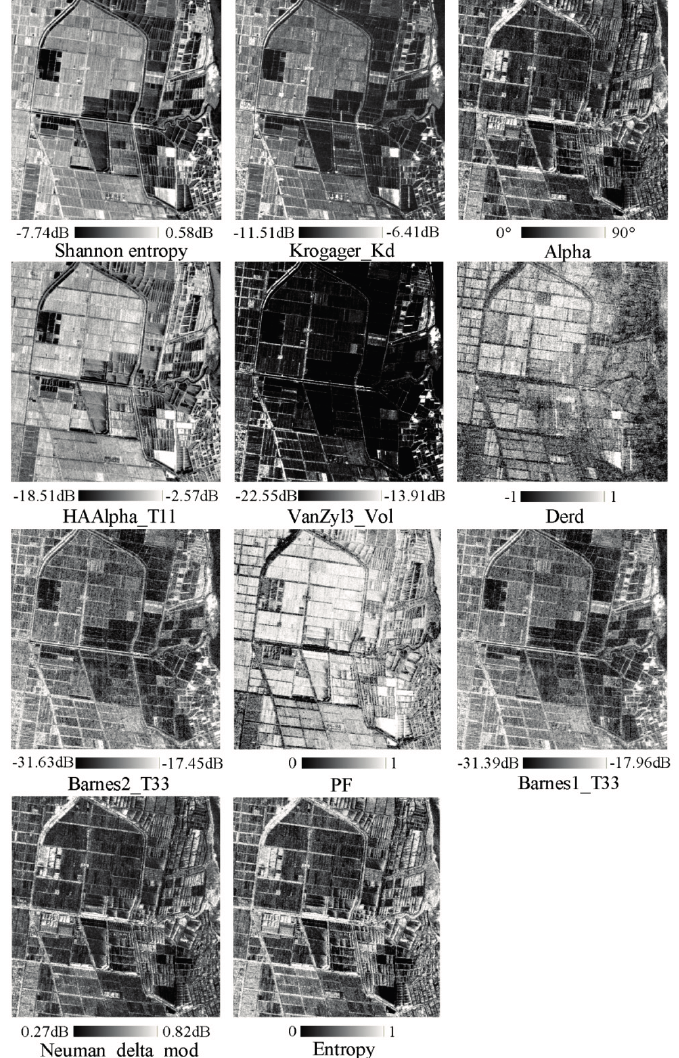
Figure 6. Polarimetric parameters selected in the decision